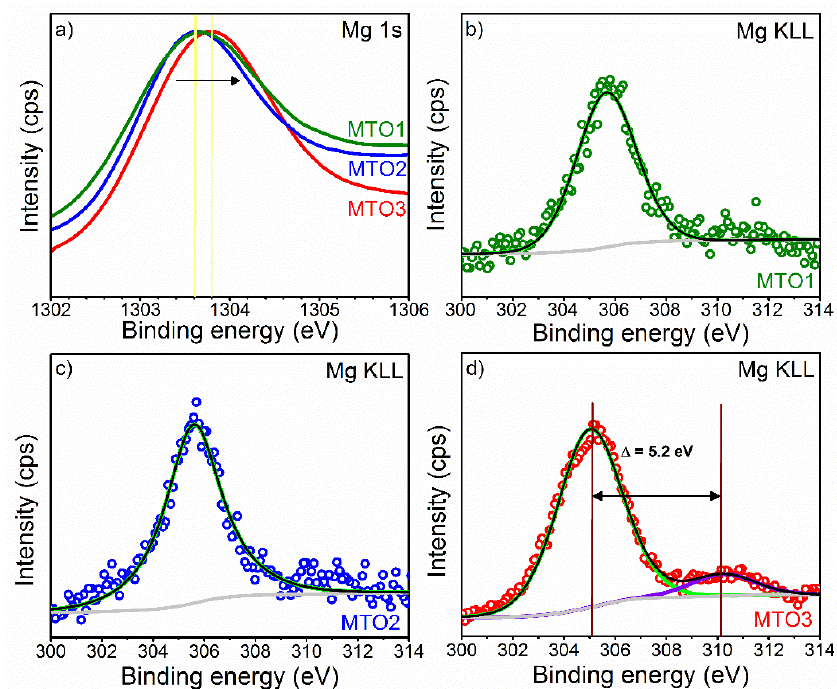
Figure 6. XPS of ( a ) Mg 1s core level spectra and ( b − d ) Mg KLL Auger spectra at MTO1, MTO2, and MTO3. The circles denote experimental data, colored lines demonstrate the deconvolution of peaks, and the black line corresponds to the sum of peaks fits (envelope).